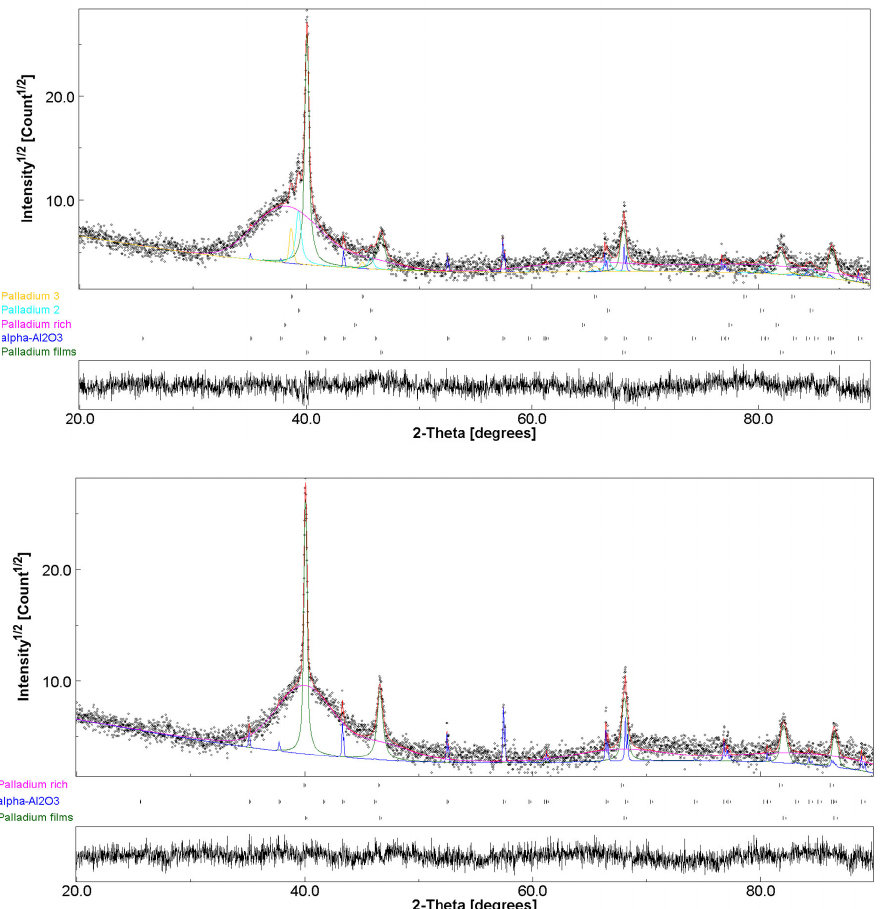
Figure 4. XRD patterns and Rietveld refinements of ZrVTiPd4 ( up ) and ZrVTiPd6 ( down ) sam ‐